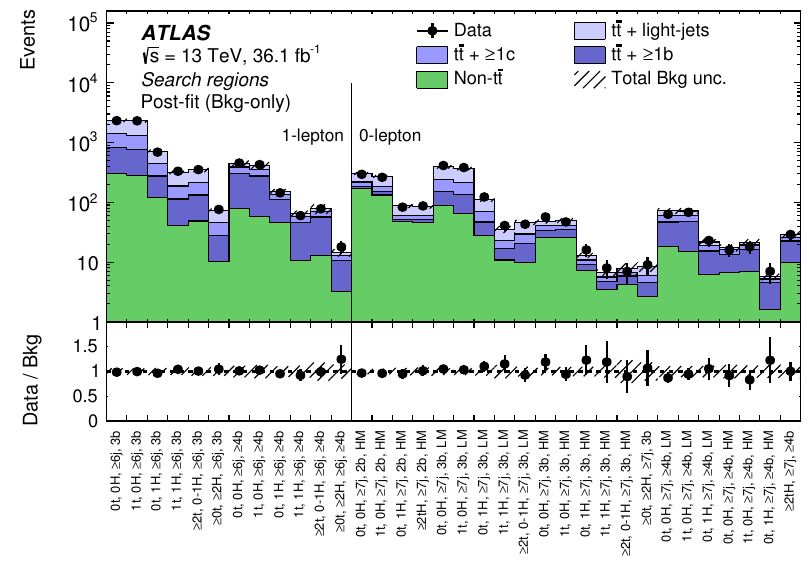
Figure 8. Comparison between the data and the background prediction for the yields in the search regions considered in the 1-lepton and 0-lepton channels, after the combined (cid:12)t to data (\Post-(cid:12)t") under the background-only hypothesis. The small contributions from t (cid:22) tV , t (cid:22) tH , single- top, W=Z +jets, diboson, and multijet backgrounds are combined into a single background source referred to as \Non- t (cid:22) t ". The bottom panel displays the ratio of data to the SM background (\Bkg") prediction. The hashed area represents the total uncertainty of the